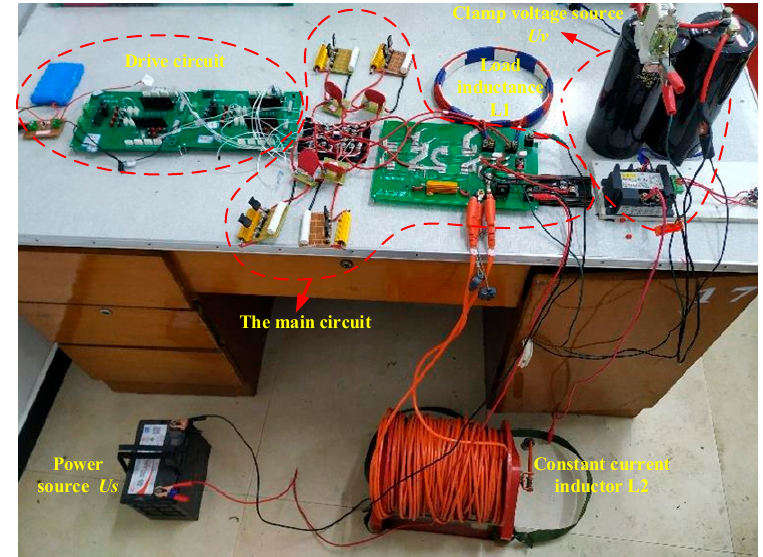
Figure 11. The photo of the main circuit in experiment. Table 1. Main device parameters of the circuit.